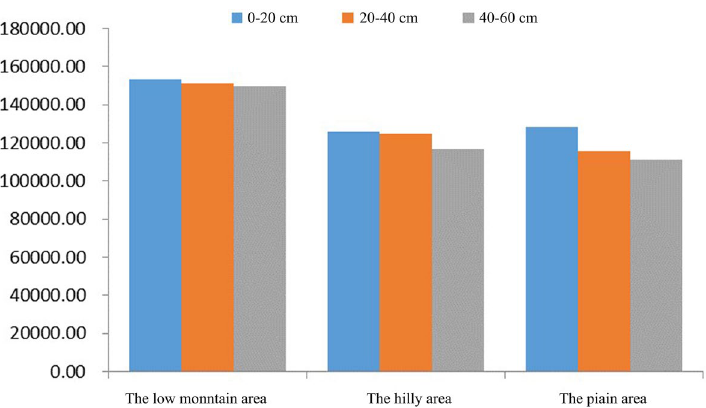
Figure 4. The soil environmental quality (represented by areas) of each depth of each geomorphic